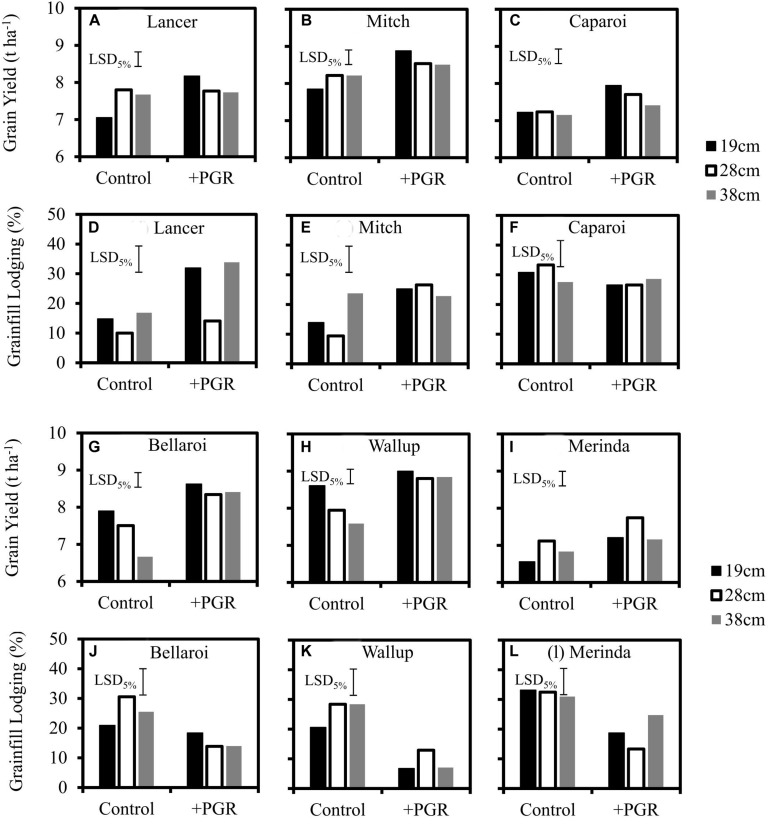
Grain yield and grainfill lodging for three row spacings in response to plus and minus PGR-mix treatments in six cultivars sown on their optimum sowing date at Spring Ridge in 2014. LSD5% represents the average LSD across all pairwise comparisons. Maximum LSD was 5% greater than average LSD, while minimum LSD was 10% below average LSD. (A–F) Grain yield and lodging for Lancer, Mitch, Caparoi. (G–L) Grain yield and lodging for Bellaroi, Wallup, Merinda.